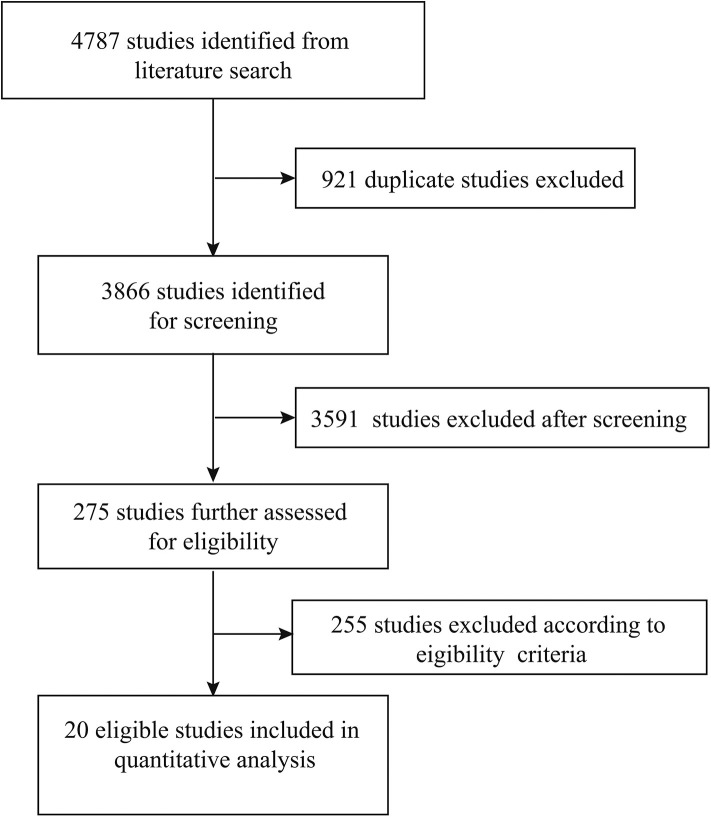
Literature search and study selection.